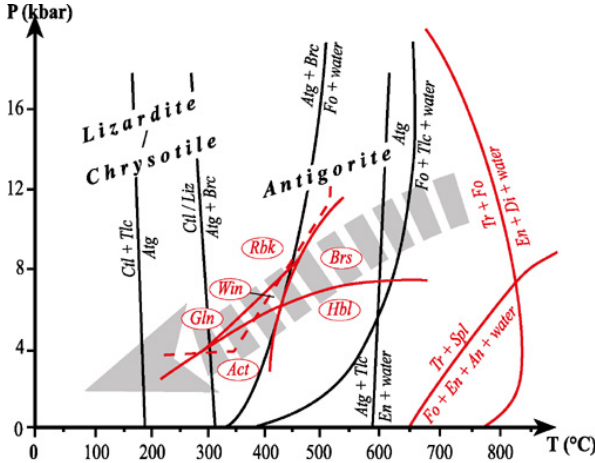
Fig. 3. Qualitative P - T conditions of stability for serpentine and amphibole minerals. Reactions for serpentines are taken from Wun- der et al. (2001); Bucher and Frey (2002); and Evans (2004). Am- phiboles fields are taken from Otsuki and Banno (1990); Parra et al. (2000); and Bucher and Frey (2002). Mineral